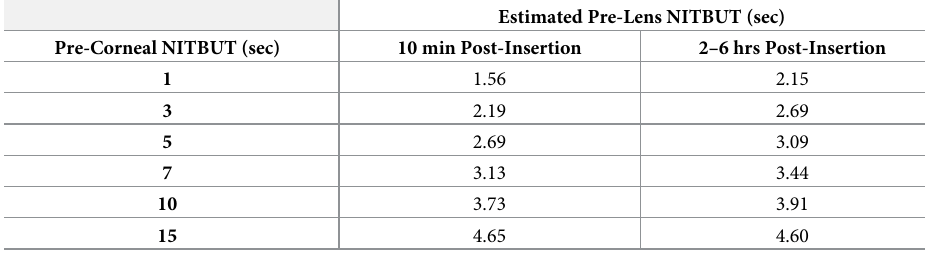
Table 1. Model estimates and estimated values of pre-lens NITBUT for various values of the pre-corneal